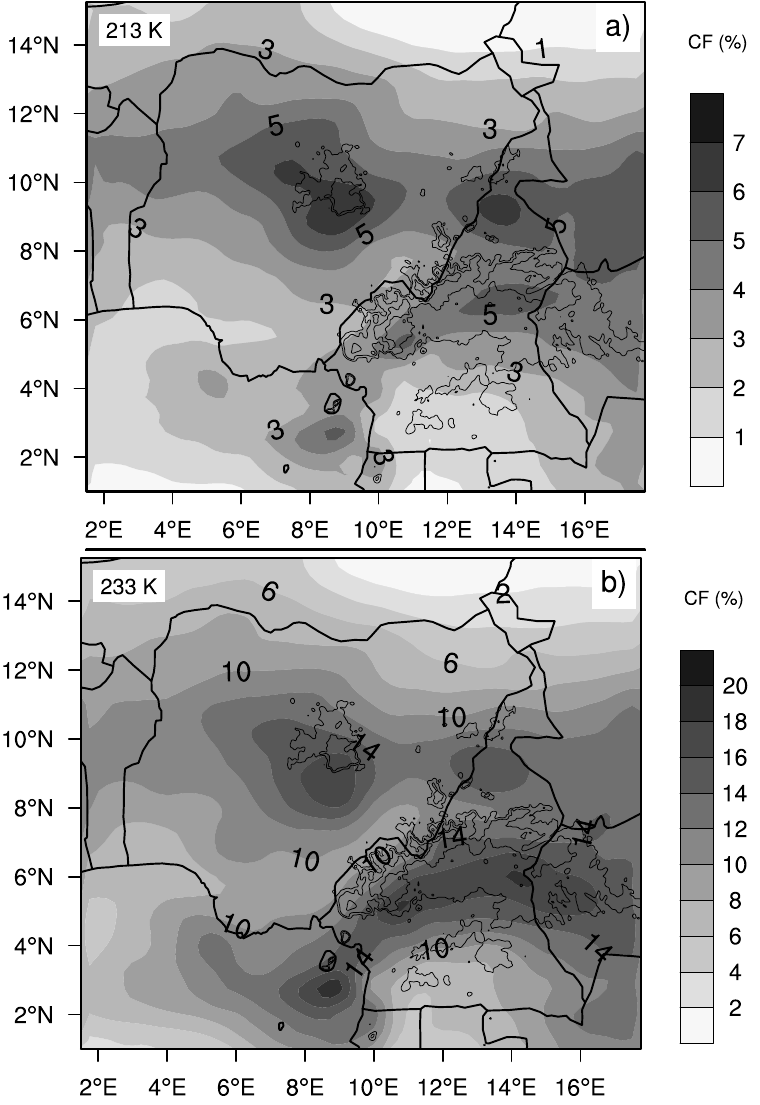
Figure 5. Mean annual spatial distribution of cloud fraction computed for a cloud-top brightness temperature threshold lower than 213 K ( a ) and than 233 K ( b ) for the entire period of June–August 1998–2002. Thin lines mark terrain elevation of 700, 1,000 and 1,500